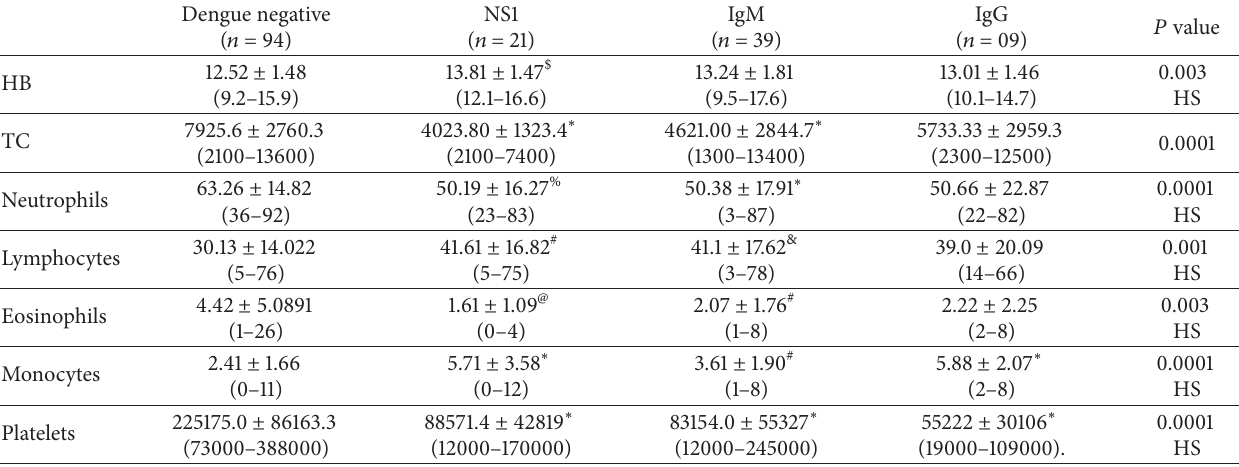
Table 3: Alterations in the haematological parameters by comparing with different stages of